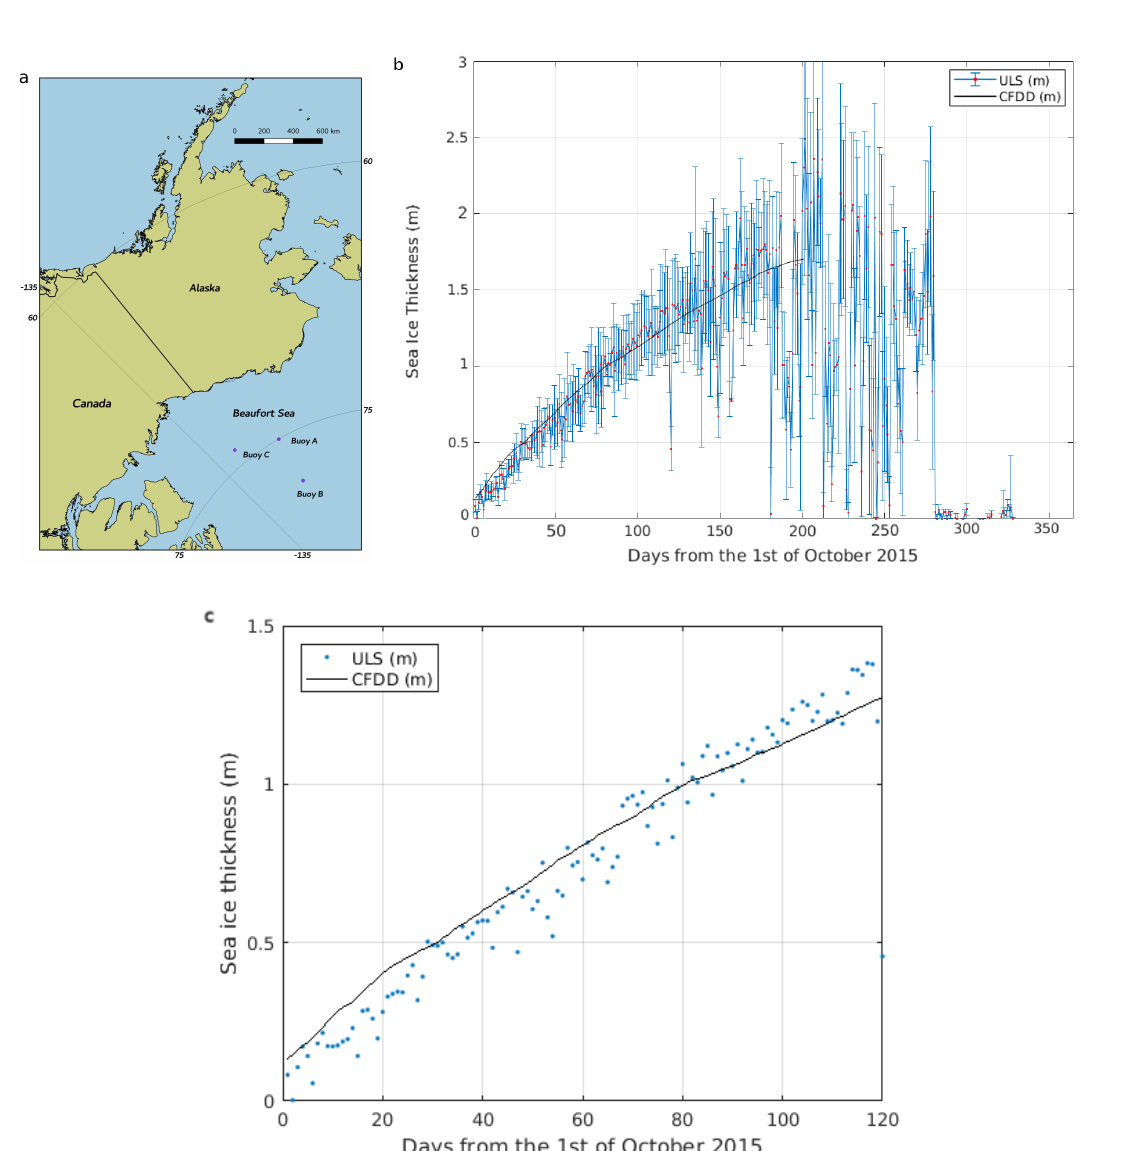
Figure 1. ( a ) Location of Woods Hole Oceanographic Institution (WHOI) buoys in the Beaufort Sea. The map uses the Arctic Polar Stereographic projection (EPSG: 3995) [40]. ( b ) Temporal evolution of the ice thickness measured by Buoy C (red dots) and modeled by Cumulative Freezing Degree Days (CFDD) (black line) over the freeze-up period in 2015. ( c ) Comparison between the modeled CFDD and Upward Looking Sonar (ULS) ground truth gathered during the first three months of the freeze-up